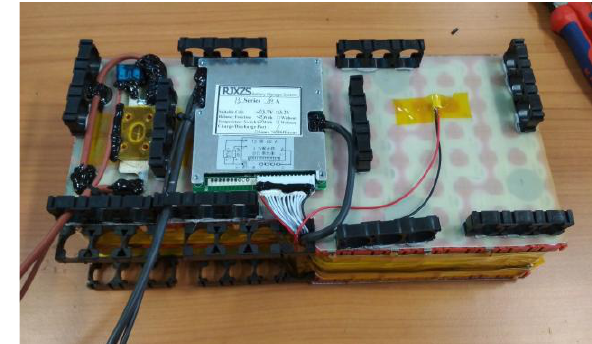
Fig. 4. Characteristics of discharging the battery in road